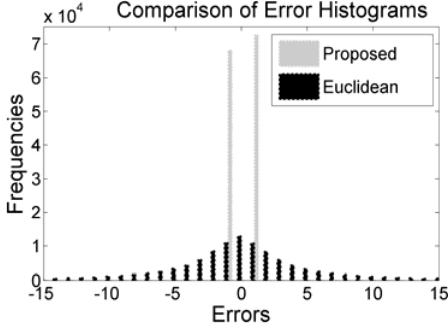
Figure 5. Comparison of histograms.